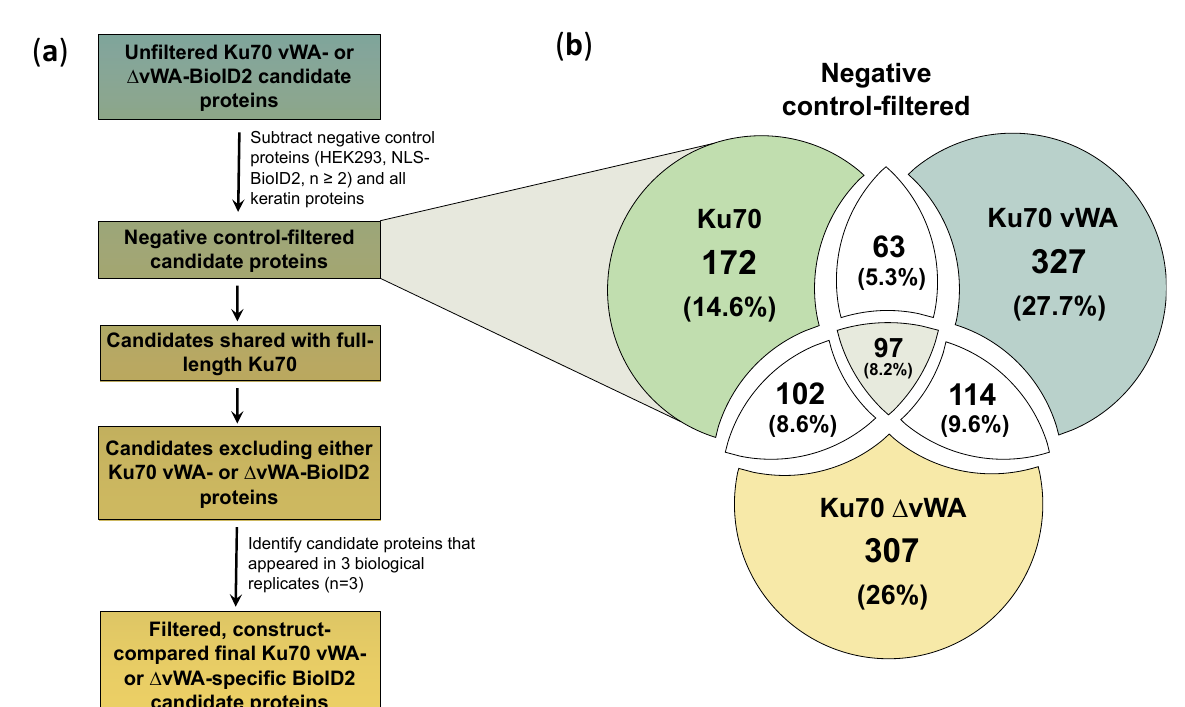
Figure 5. Filtering process and steps to compare filtered candidate BioID2 proteins; ( a ) Ku70 vWA-specific or Ku70 ∆ vWA- specific candidates were first filtered by subtracting negative control proteins identified in two or more biological MS replicates (n ≥ 2) of either the HEK293 cell line or the NLS-BioID2 cell line. Additionally, all keratin proteins were removed. Next, all remaining candidates were compared to identify those that were shared with full-length Ku70 and missing from the mutually exclusive deletion construct (either Ku70 vWA or Ku70 ∆ vWA). Finally, only candidates that appeared in all 3 biological replicates of Ku70 vWA or Ku70 ∆ vWA were selected for further discussion and validation; ( b ) Venn diagram comparing the total number of negative-control and keratin filtered proteins for full-length wild-type Ku70-BioID2, Ku70 vWA-NLS-BioID2, and Ku70 ∆